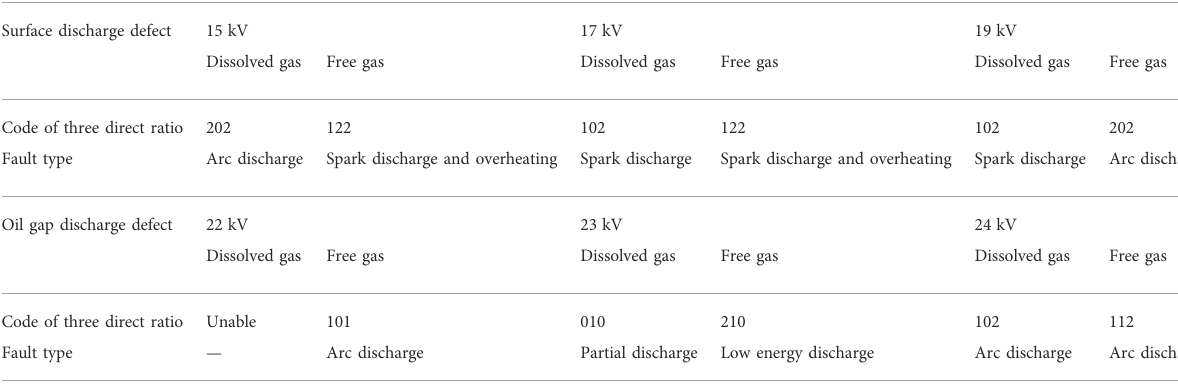
Surface discharge